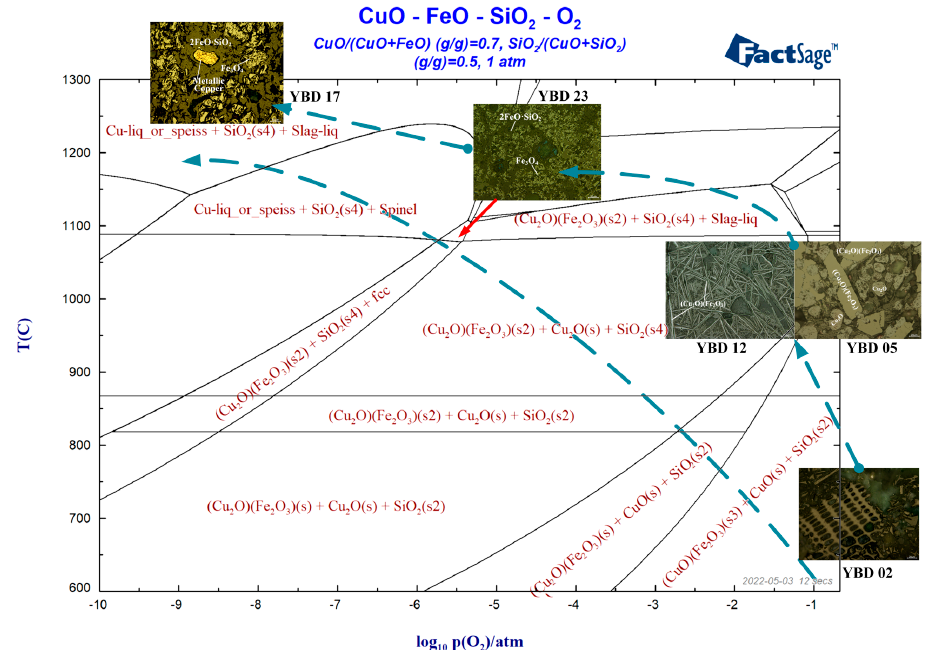
Figure 29. Temperature–oxygen potential phase diagram of slag from Yubeidi Site .